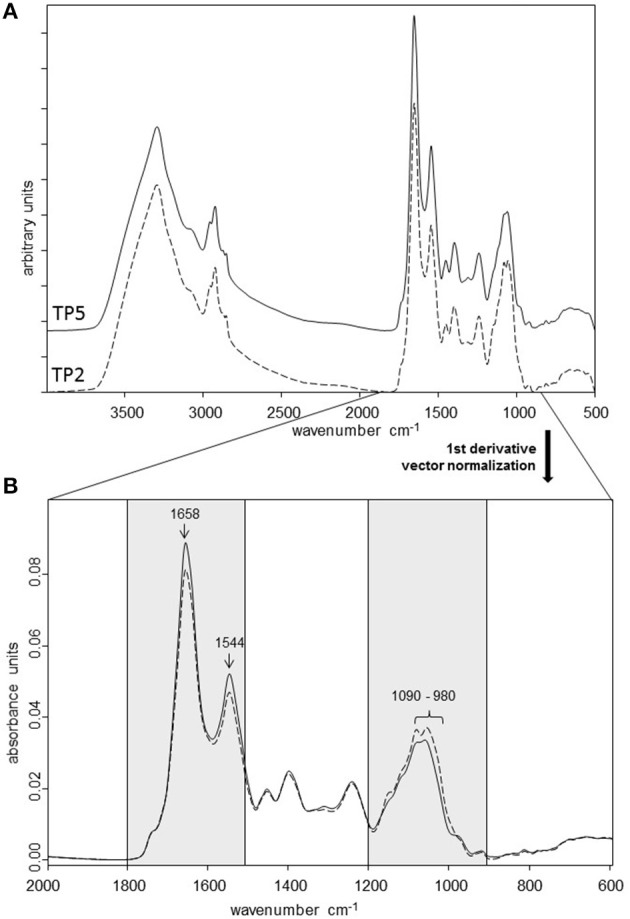
(A) FTIR spectra from TP2 and TP5 recorded in the transmission mode at 4,000 to 500 cm−1. First derivative, normalized average FTIR spectra of three independent measurements of TP2 and TP5. (B) Spectra are shown from the spectral range with the most pronounced differences between the two strains (amide/protein region: 1,800 to 1,500 cm−1; polysaccharide region: 1,200 to 900 cm−1).